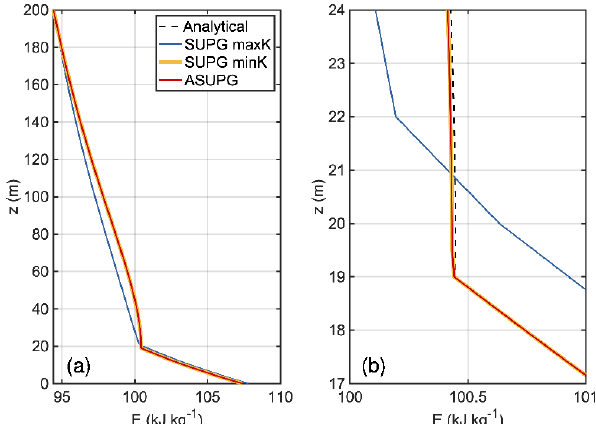
Figure 7. Simulated steady-state profiles of the enthalpy E for the three different SUPG models by employing the geometric mean (Eq. 16) and a vertical resolution of (cid:49)z = 0 . 5m (a) . Zoom to CTS region (b) . Please note that ASUPG and SUPG minK overlay each